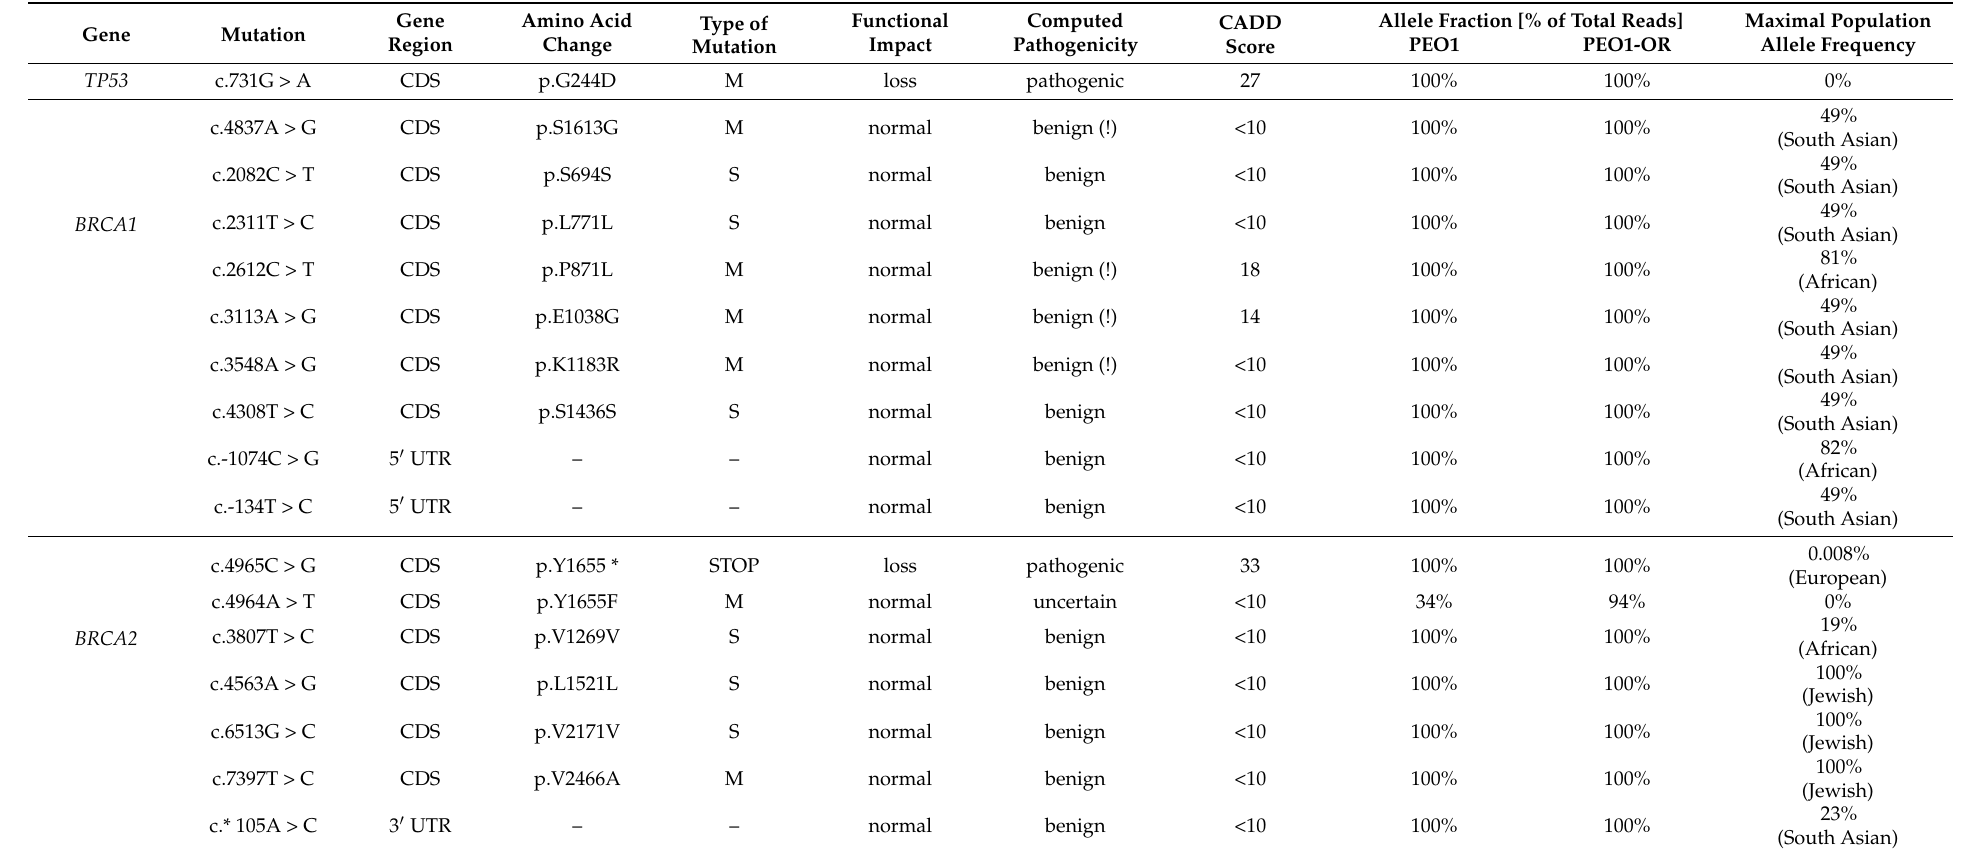
Table 1. Whole-exome sequencing-based detection of high-quality exonic variants detected in ABCB1 , ATR , BRCA1 , BRCA2 , CHEK1 , H2AX , PARP1 , and TP53 genes in PEO1 and PEO1-OR cell